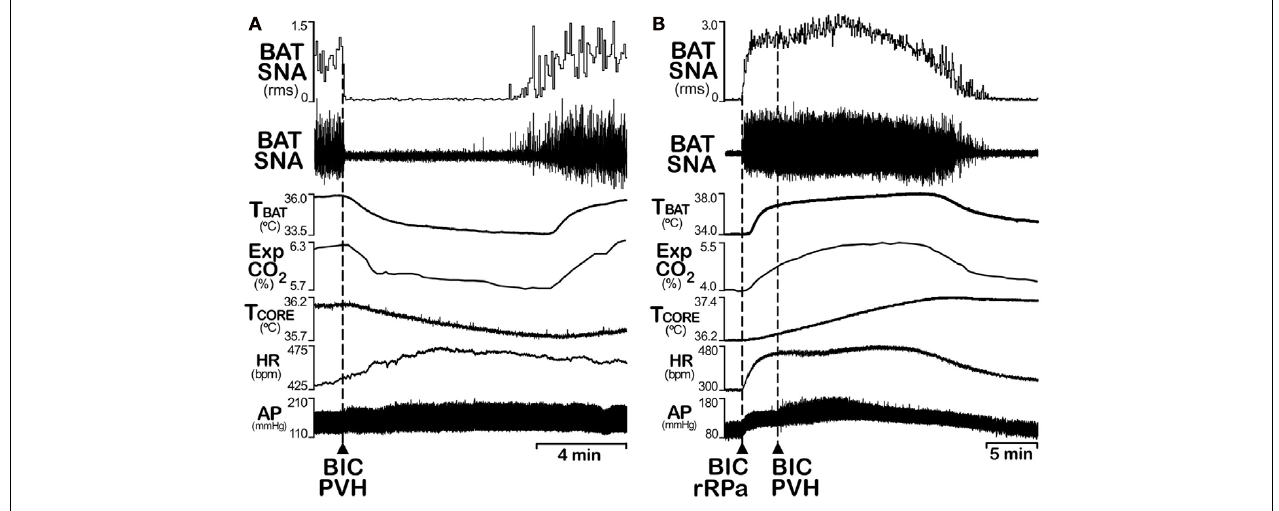
produced by whole body cooling. Core body temperature (TCORE) was also reduced; heart rate (HR) and arterial pressure (AP) were increased by BIC in PVH. (B) The increases in BAT SNA,TBAT, expired CO 2 ,TCORE, HR, and AP evoked by nanoinjection of BIC into the rRPa are not affected by nanoinjection of BIC into the PVH. Modified with permission from Madden and Morrison (2009).